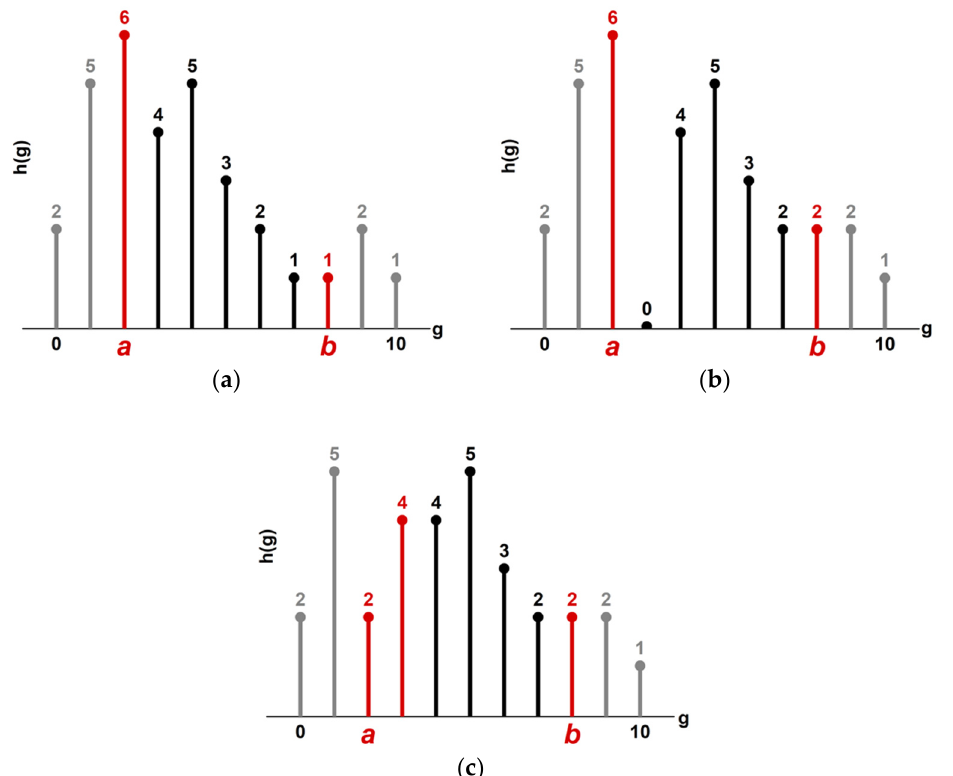
Figure 6. Proposed embedding procedure with a minimum bin: ( a ) original histogram; ( b ) shifted histogram; ( c ) histogram with concealed data.